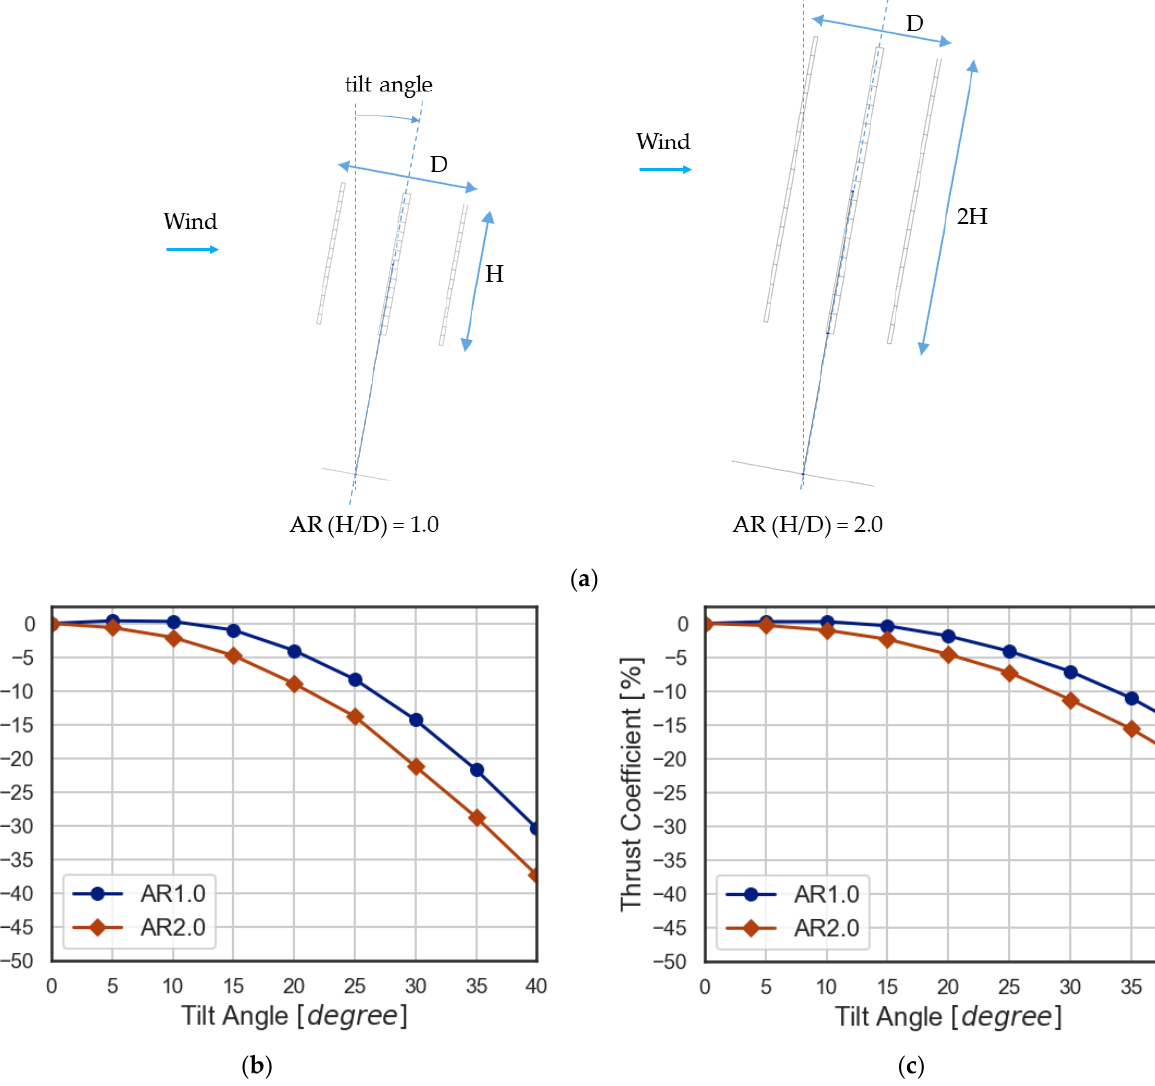
Figure 5. Difference in Power and Thrust Coefficients of a tilted rotor compared to an upright one: ( a ) configuration of the simulation; ( b ) power coefficient; ( c ) thrust coefficient.